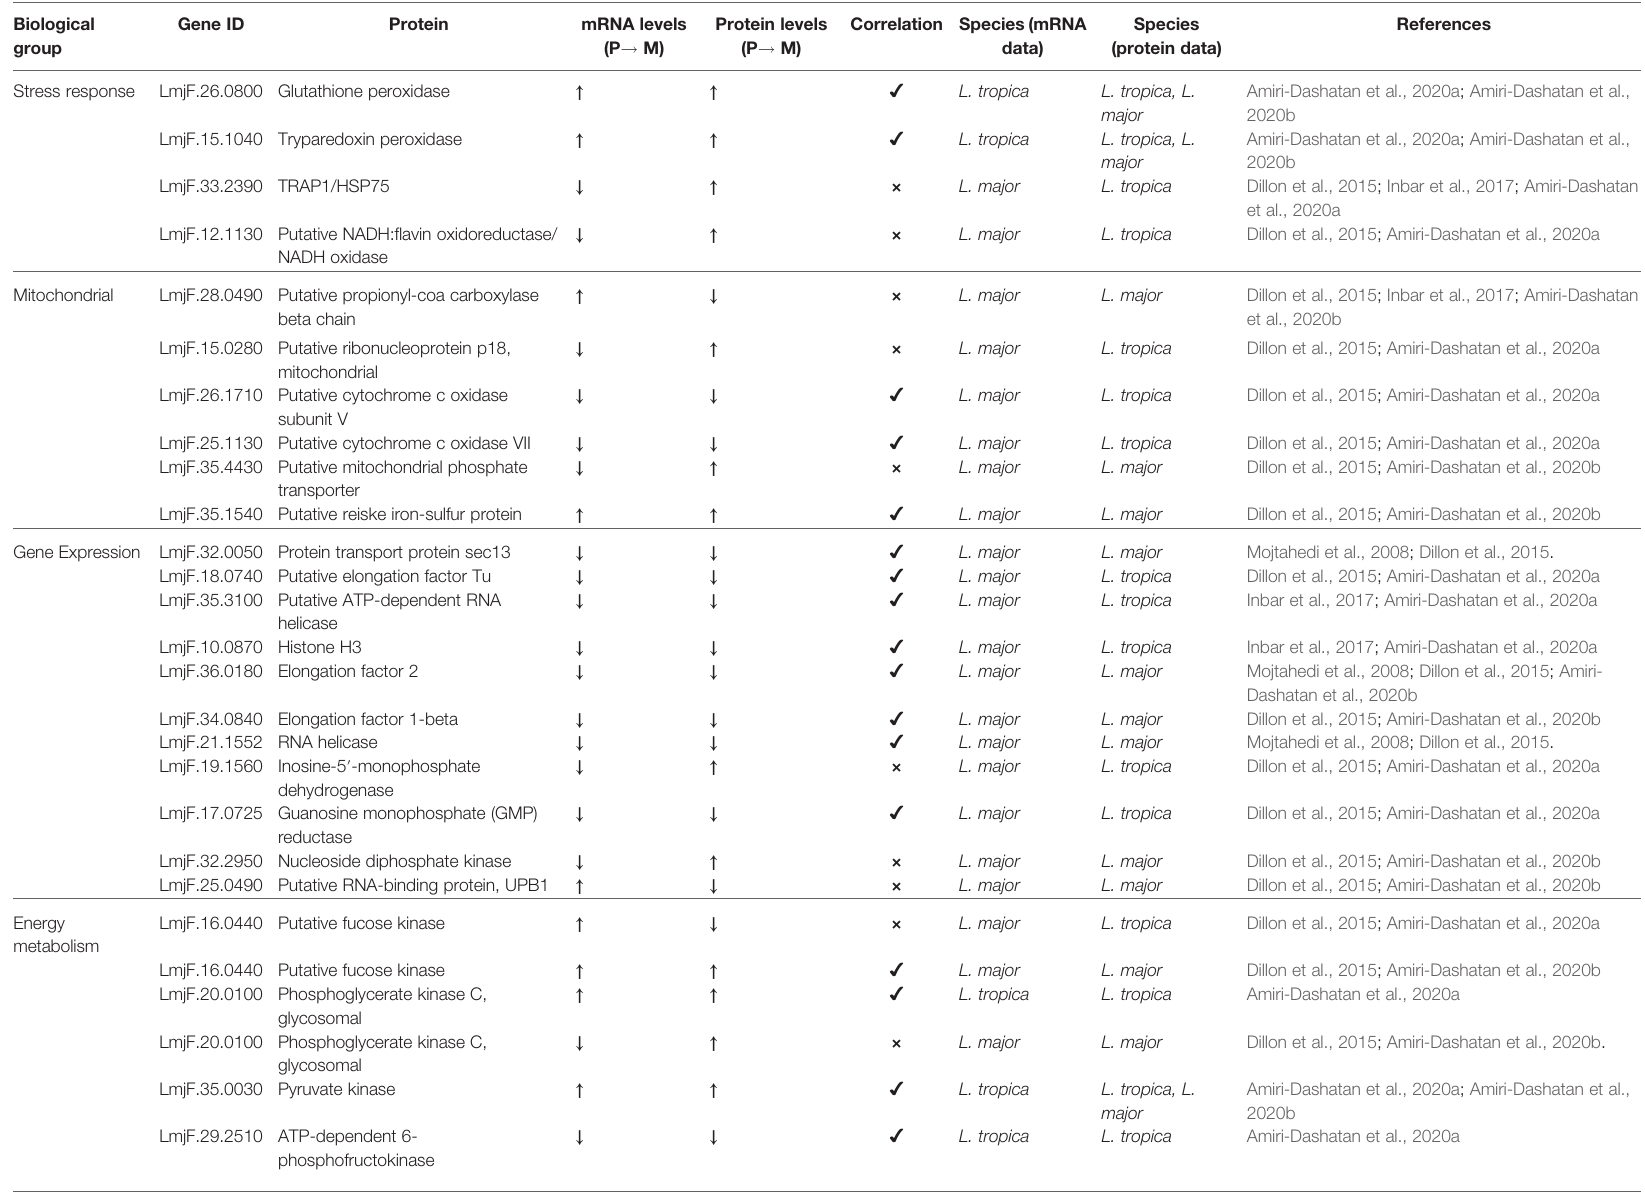
TABLE 1 | Common genes found in independent transcriptomic and proteomic data obtained from metacyclogenesis (procyclic vs. metacyclicpromastigotes) differentiation. Biological